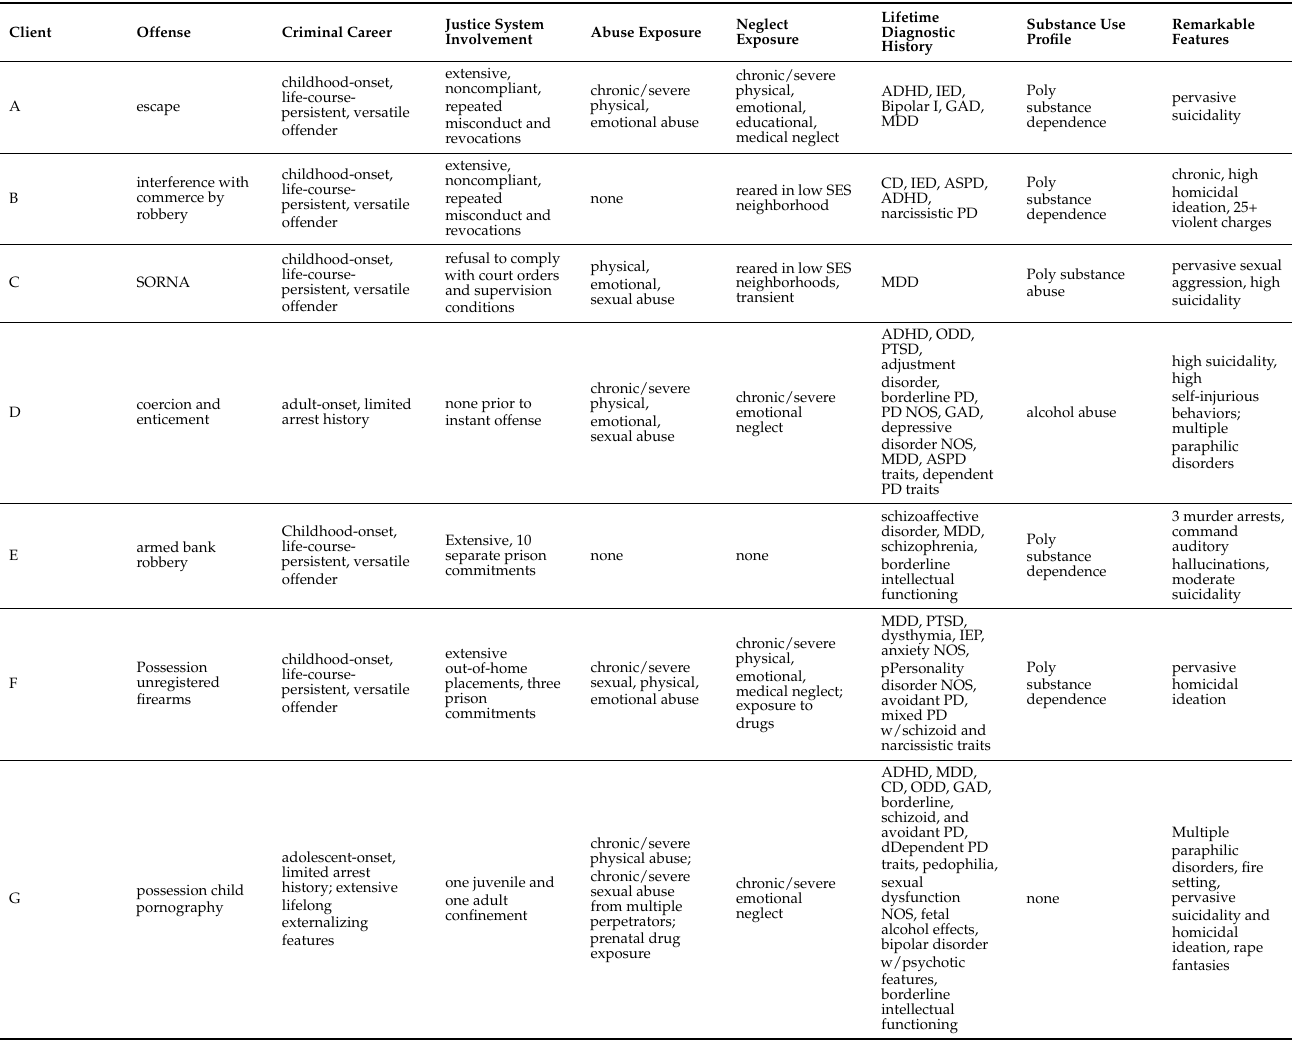
Table 1. Case report